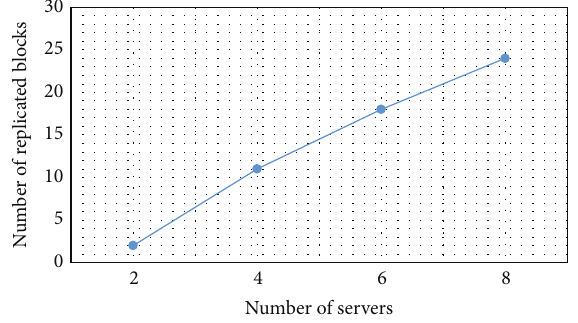
Figure 11: Effect of number of servers on blocks